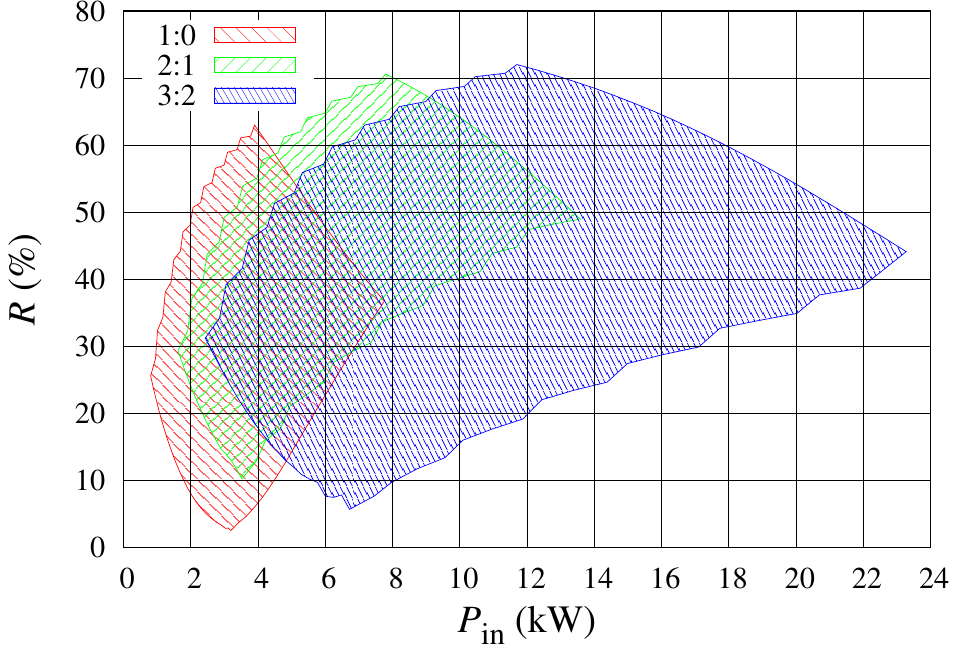
Figure 6. R for different BWRO configurations using sample 11 (Table 1) as C f